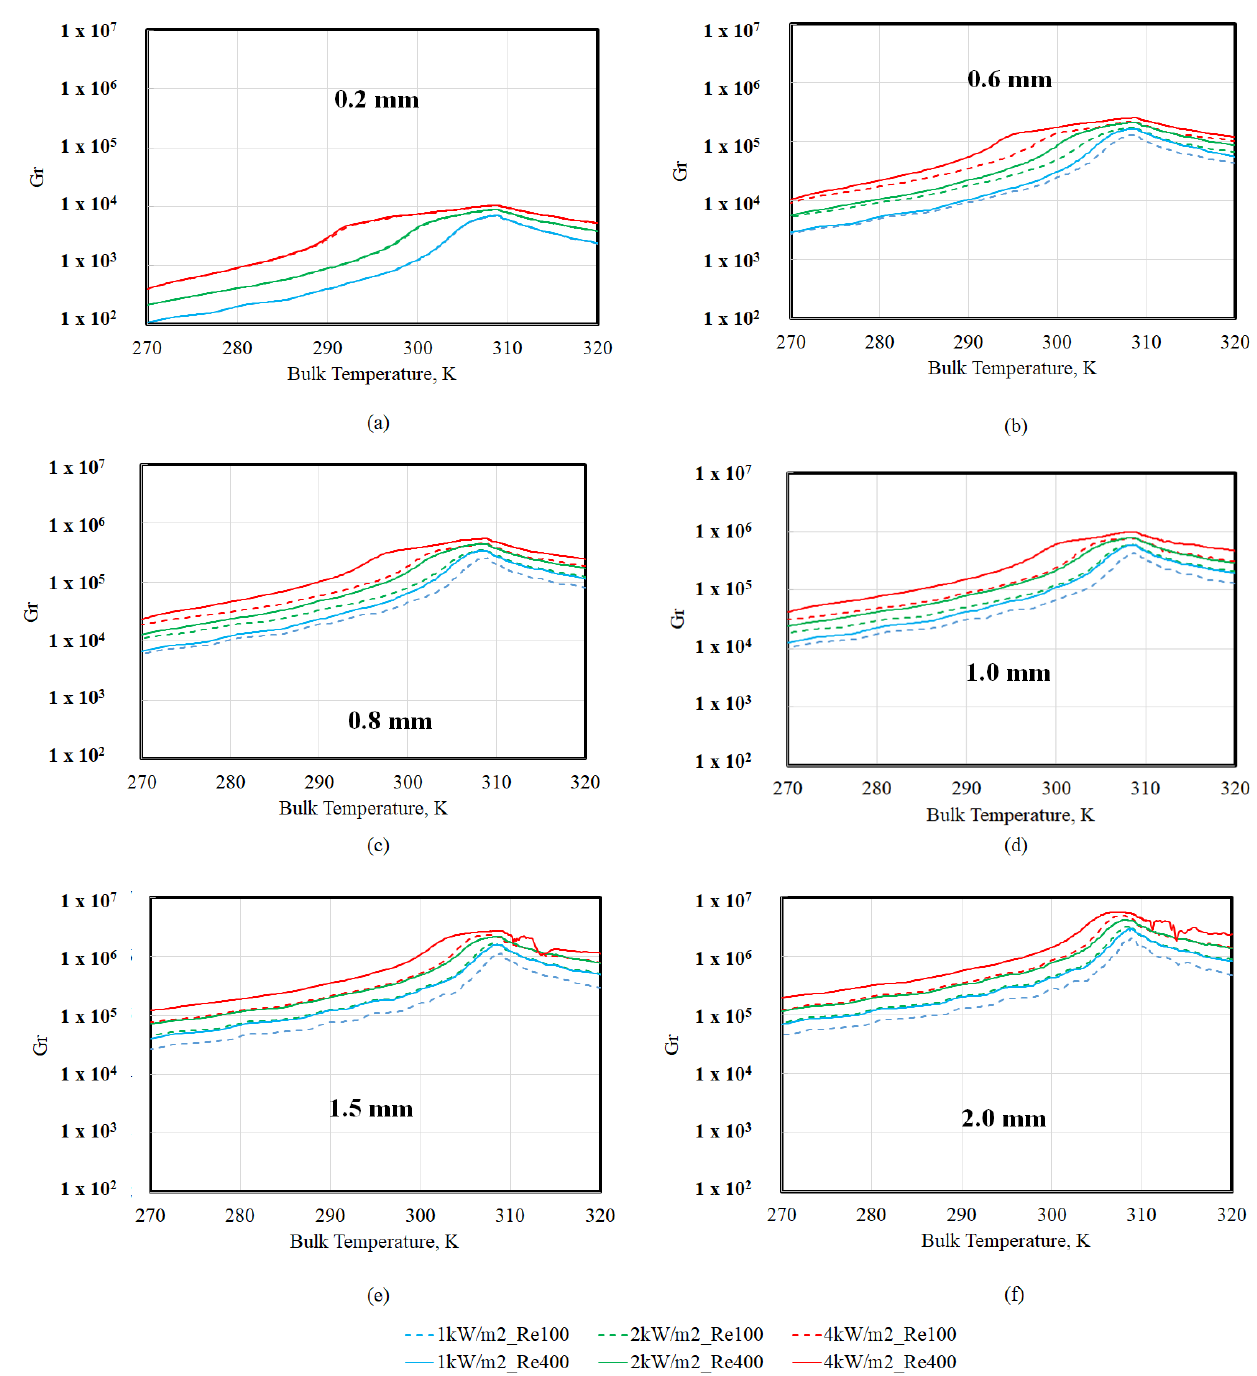
Figure 5. Gr versus bulk temperature (T BULK ) at different tube diameters: ( a ) 0.2 mm; ( b ) 0.6 mm; ( c ) 0.8 mm; ( d ) 1.0 mm; ( e ) 1.5 mm; ( f ) 2 mm. ( c ) 0.8 mm; ( d ) 1.0 mm; ( e ) 1.5 mm; ( f ) 2